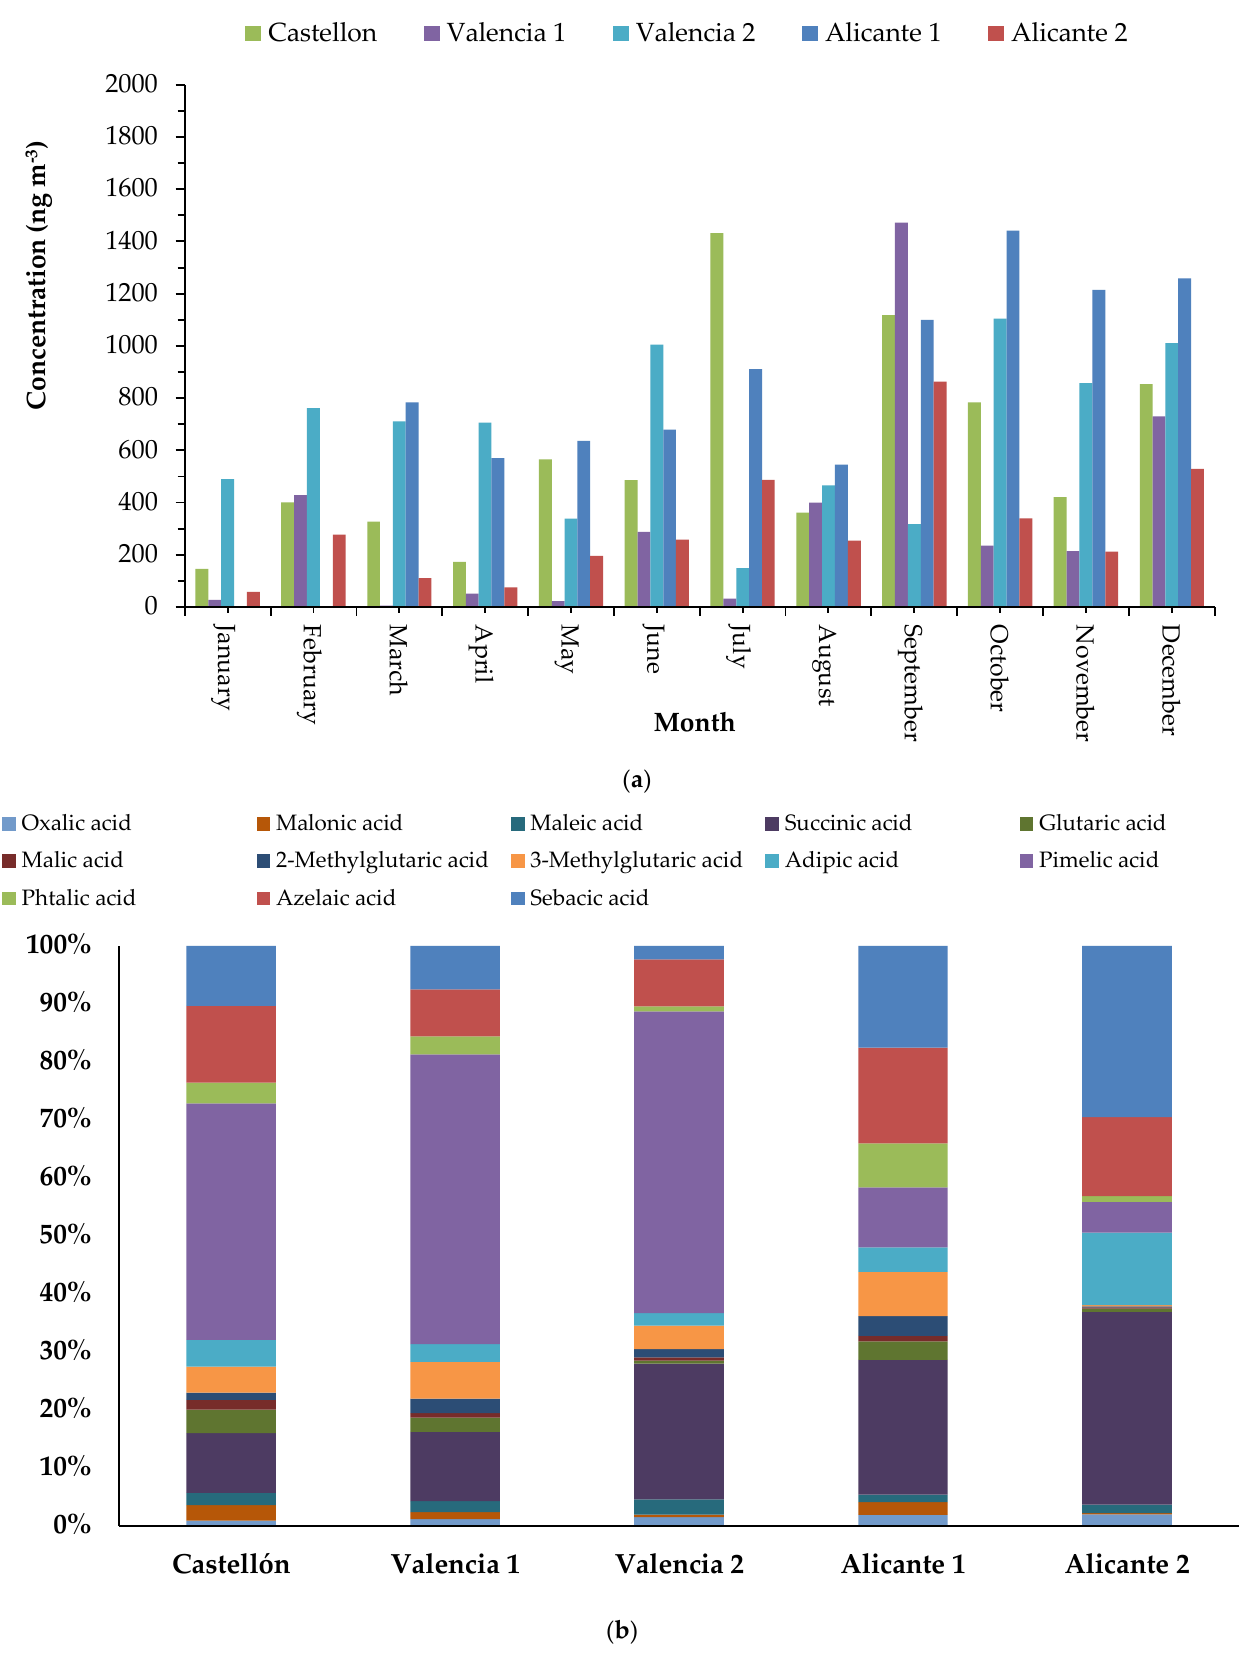
Figure 2. ( a ) Monthly trends of main DCA species (C2 to C9); ( b ) average concentrations of DCAs (in percentage) in fine PM in 5 western Mediterranean areas studied.